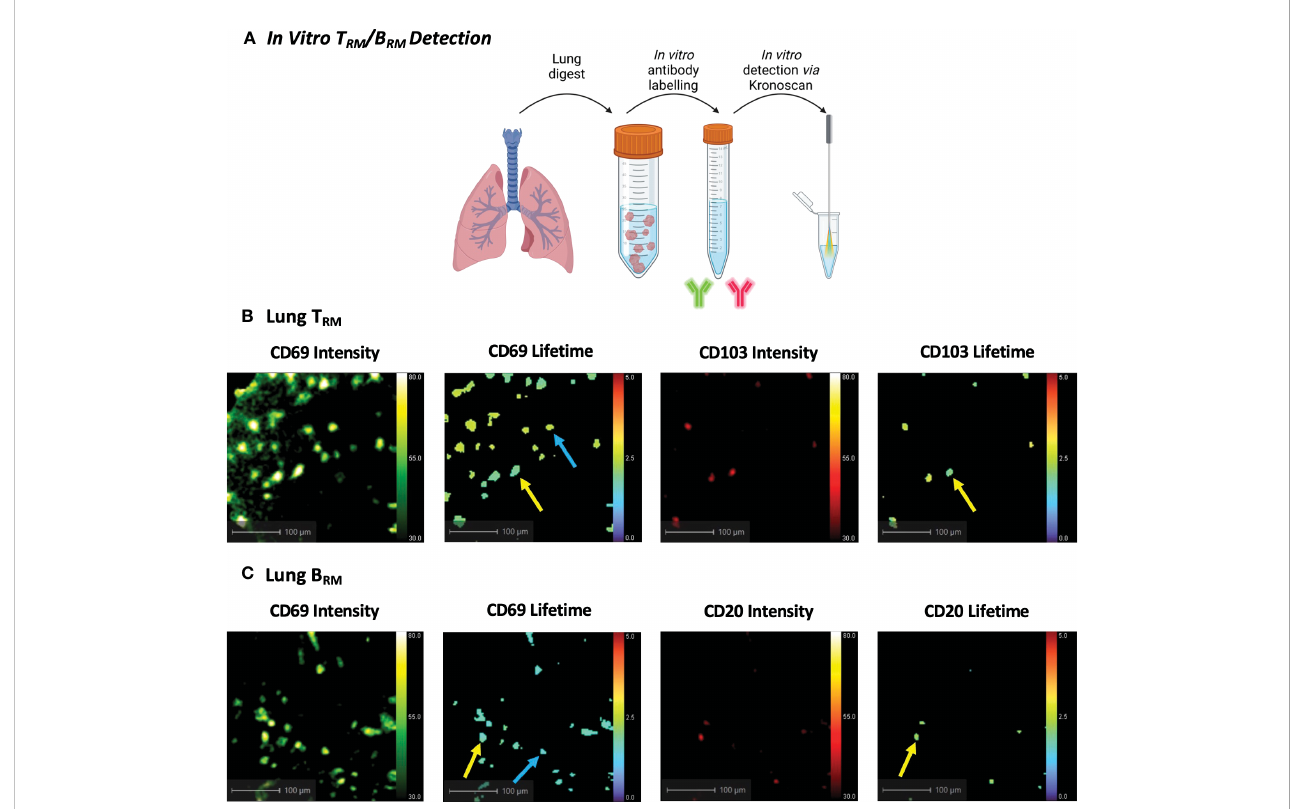
FIGURE 4 In Vitro Human T RM and B RM Detection using KronoScan and Panoptes . (A) Cells from human lung tissue digests were stained with T RM or B RM antibodies and imaged in vitro using KronoScan imaging system and Panoptes multifunctional fi bre. (B) Human T RM detection. T RM were detected via expression of CD69 and CD103. Blue arrow indicates CD69 + cells and yellow arrow points CD69 + CD103 + T RM. (C) Human B RM detection. Blue arrow indicates CD69 + cells and yellow arrow points CD69 + CD20 + B RM . Representative images from n=3